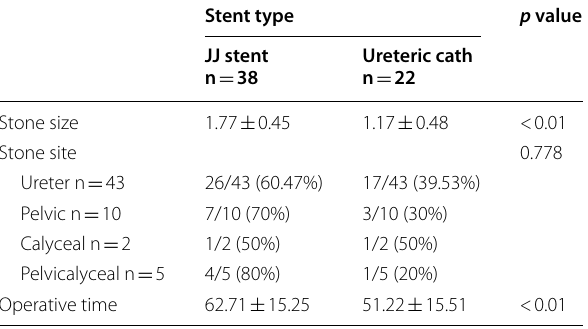
Table 7 Parameters affecting type of stent at the end of the